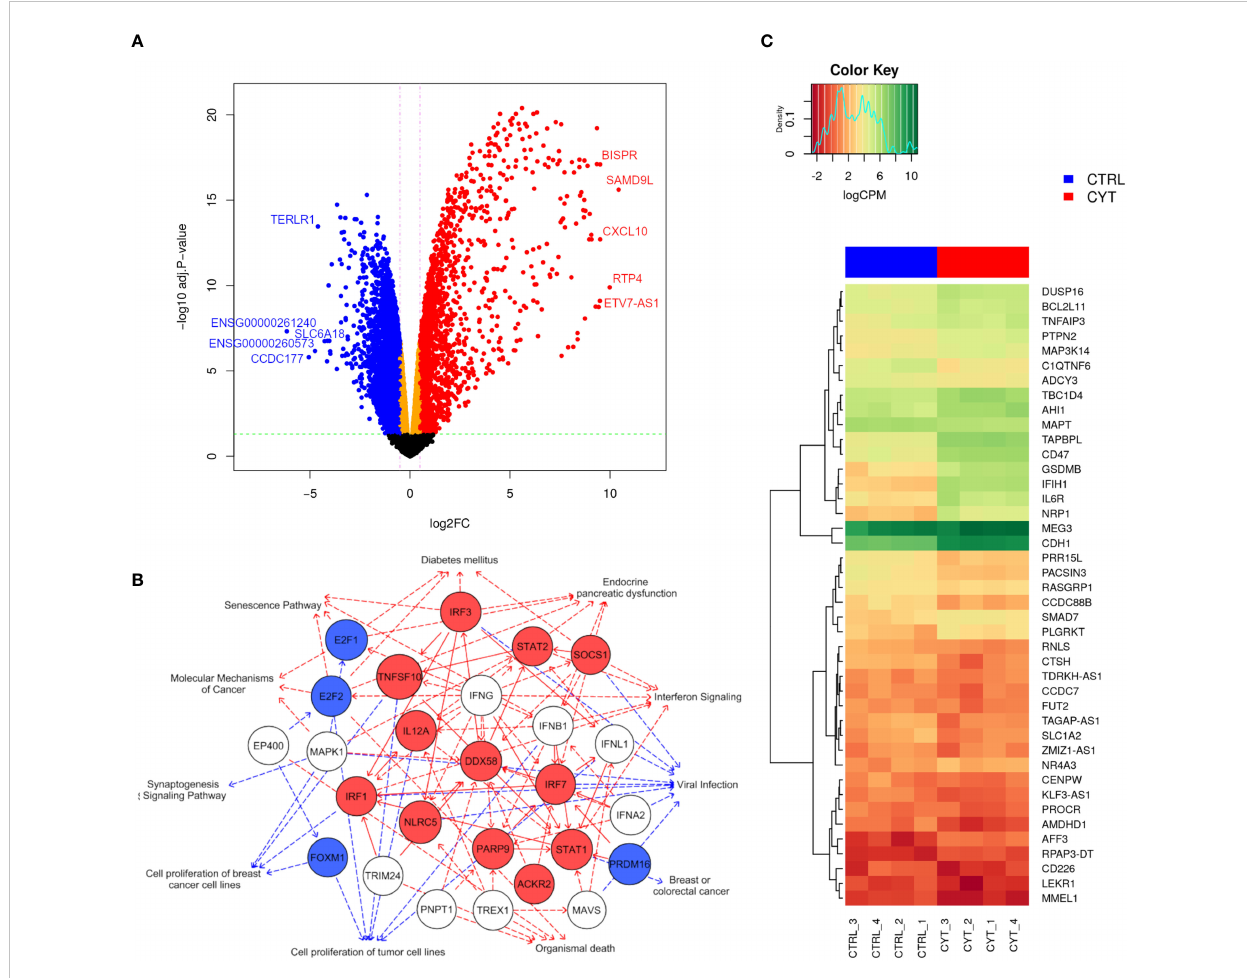
FIGURE 5 Cytokines modulate a large part of the gene expression pro fi le of EndoC- b H5 cells. RNA sequencing of 4 replicates of untreated control cells (CTRL_1-4) or cells exposed to cytokines (50 U/mL IL-1 b , 1000 U/mL IFN g and 1000 U/mL TNF a ) for 48 h. (A) Volcano plot showing differentially expressed genes after exposure to cytokines compared to untreated cells. The horizontal line represents the adjusted p-value and the vertical line represent fold change cut-offs. The red and blue dots represent the upregulated and downregulated genes, respectively. Top 5 most up- and downregulated mRNAs/lncRNAs ranked based on log-fold changes (logFC) are shown in the plot. (B) Graphical summary network representing the most signi fi cant upstream regulators, diseases, functions, and pathways, and their relations, as predicted by the IPA Core analysis. Red edges: predicted activated pathways, blue edges: predicted inhibited pathways. Solid lines represent direct relationships and dashed lines represent indirect relationships. Red nodes: upregulated, blue nodes: downregulated, white nodes: non-affected, based on differential expression from dataset. (C) Heat map and hierarchical clustering of the 42 differentially expressed candidate genes mapping to type 1 diabetes